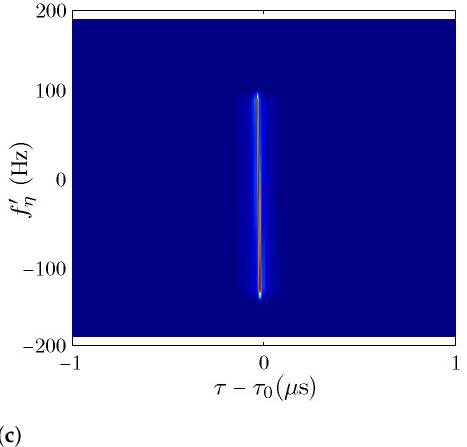
Figure 24. Signals from a point target, ( a ) after deramping with method in [1], ( b ) after tackling ASA issue with method in [2], and ( c ) after solving ASA with proposed